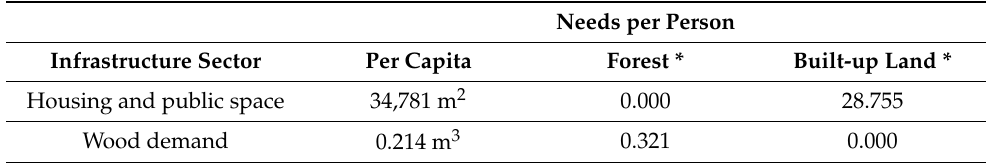
Table 6. Ecological footprint or land demand per person of the infrastructure sector in Java Island.